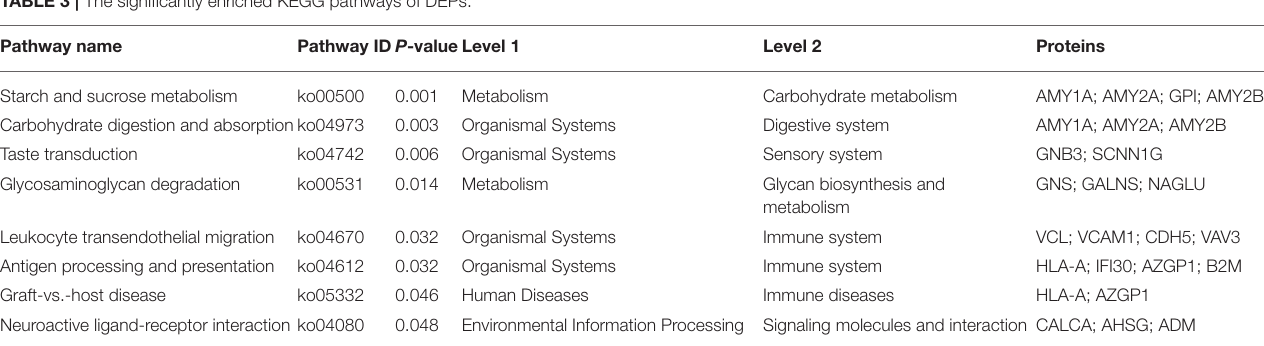
TABLE 3 | The significantly enriched KEGG pathways of